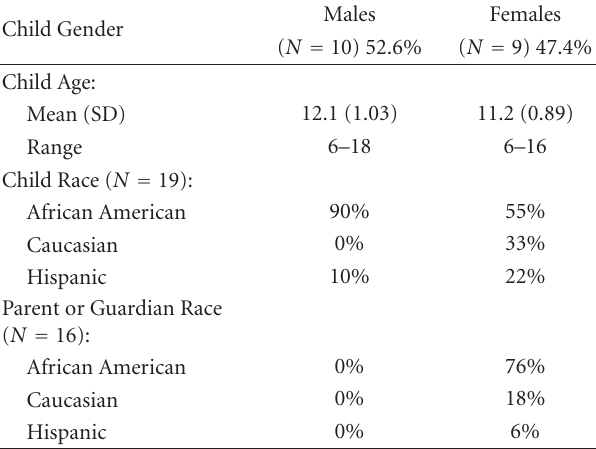
Table 1: Demographics of Children and Mothers or Guardians. Child